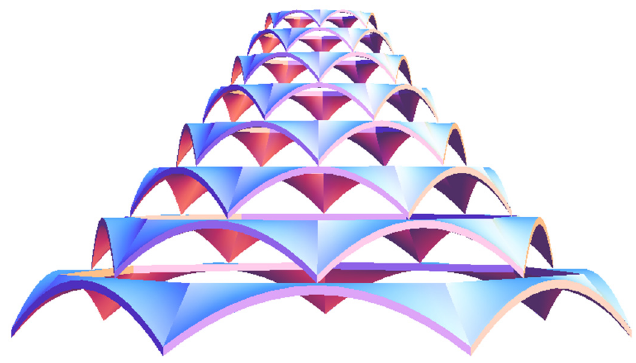
Figure 33. Proposal of an eight-tiered Buddhist monument. Elevation.